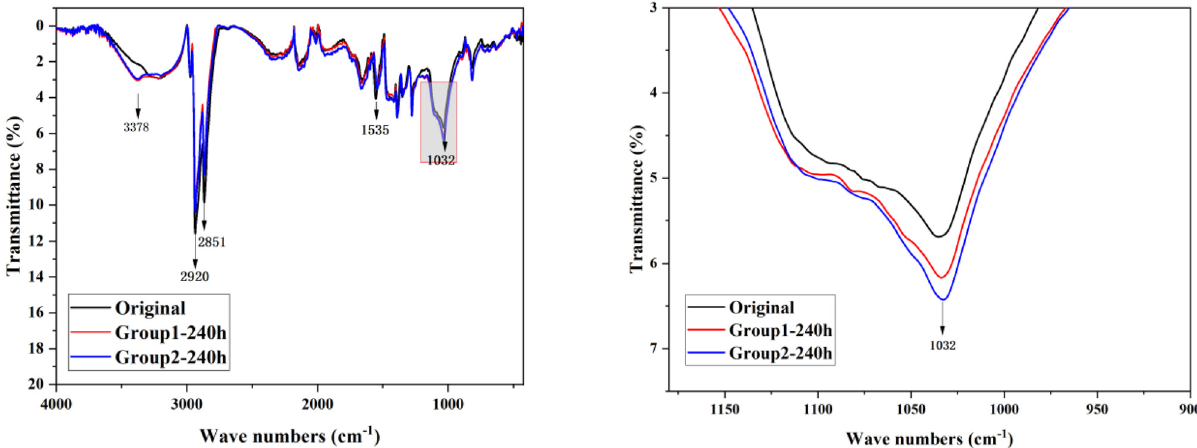
Figure 8: ATR - FTIR spectra of the EPDM samples.